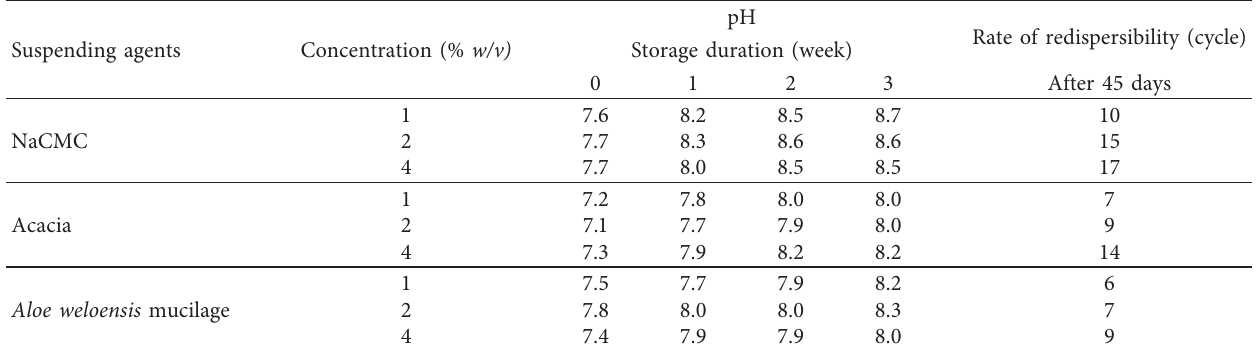
Table 5: Rate of redispersibility and pH of ZnO suspensions formulated from the three suspending agents. Suspending